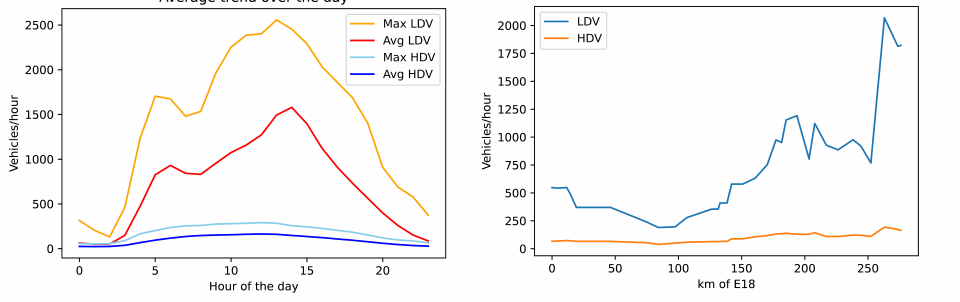
Figure 7. Traffic